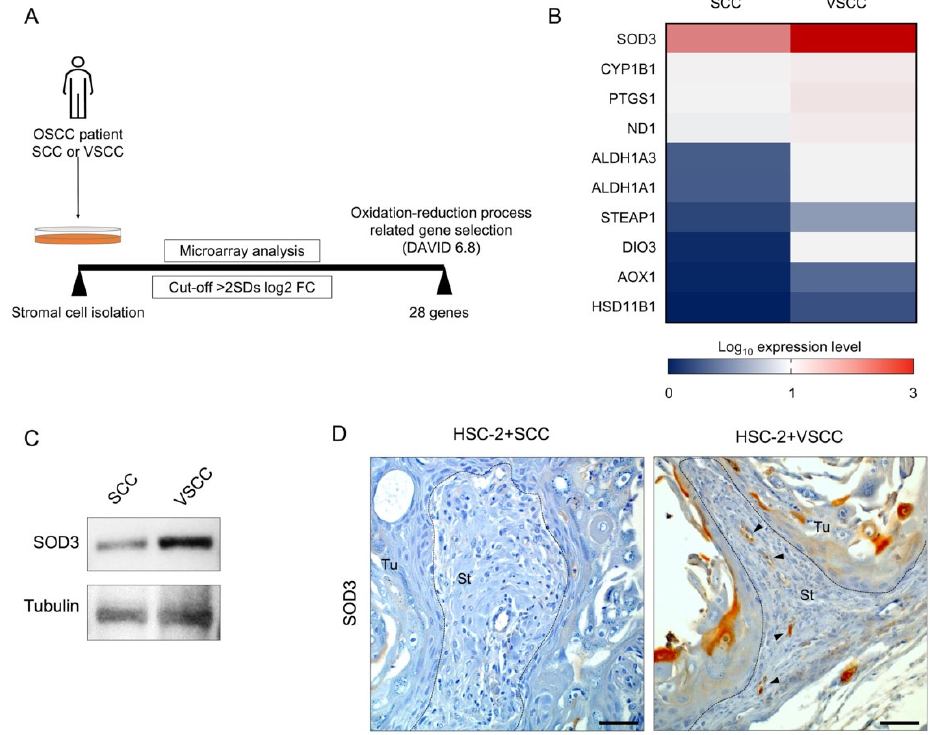
Figure 3. SOD3 expression is higher in low-invasive VSCC stroma than in high-invasive SCC stroma. ( A ) Illustration of oxidation-reduction process-related genes screening. We analyzed the differentially expressed genes (DEGs) of low-invasive VSCC and high-invasive SCC with more than 2 times the standard deviation of fold change cut-off. We selected oxidation-reduction process-related genes by DAVID Bioinformatics Resources 6.8. ( B ) Heatmap presentation of the expression level of oxidation-reduction related genes in SCC stromal cells and VSCC stromal cells. ( C ) Detection of SOD3 in high invasive stromal cells and low invasive stromal cells by western blotting. ( D ) Representative images of SOD3 IHC staining. Arrows indicate SOD3 + cells. Dotted lines represent the boundary of the tumor (Tu) and stroma (St) area. Scale bars: 50 µ